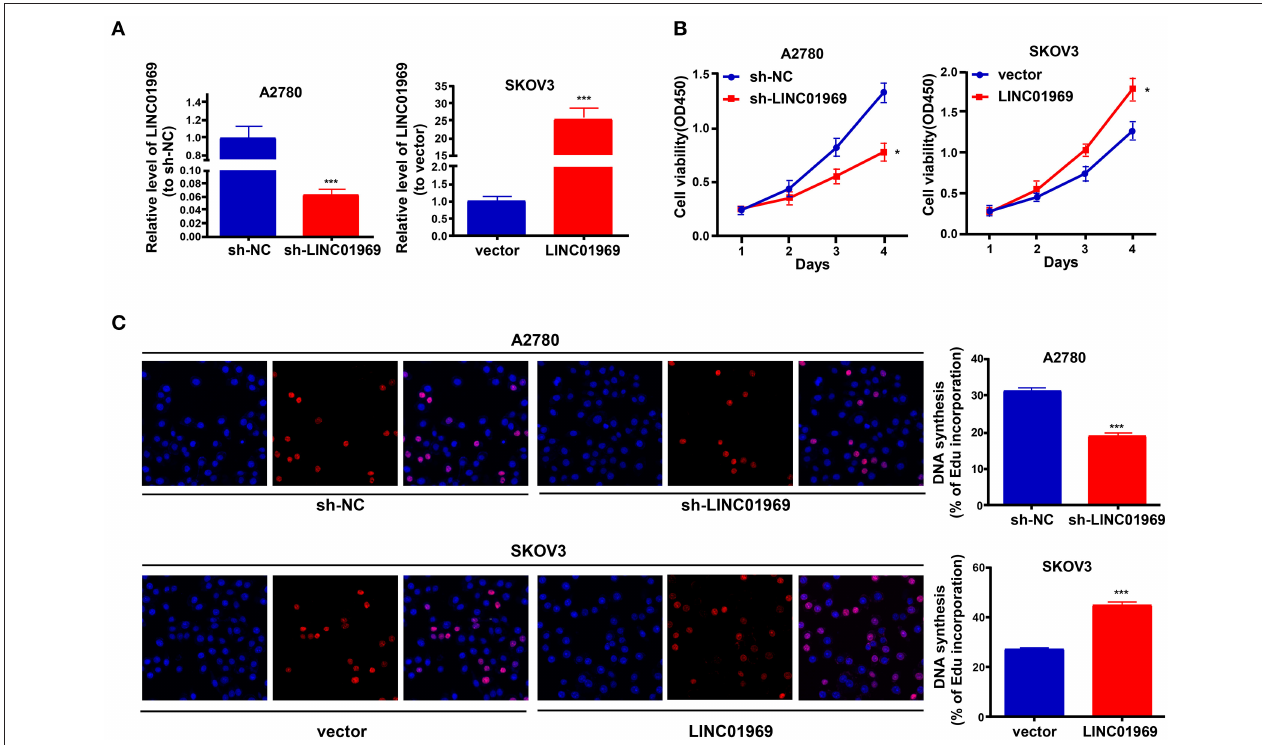
FIGURE 3 | LINC01969 promotes cell growth in ovarian cancer (OC) cells. (A) Transfection efficiency of sh- LINC01969 and LINC01969 -overexpressing vector. (B) Cell viability was analyzed by CCK-8 assay. (C) EdU assay indicated that LINC01969 silencing delayed OC cell proliferation. Data were presented as represent the mean ± SD of three independent experiments; * P < 0.05, *** P < 0.001.